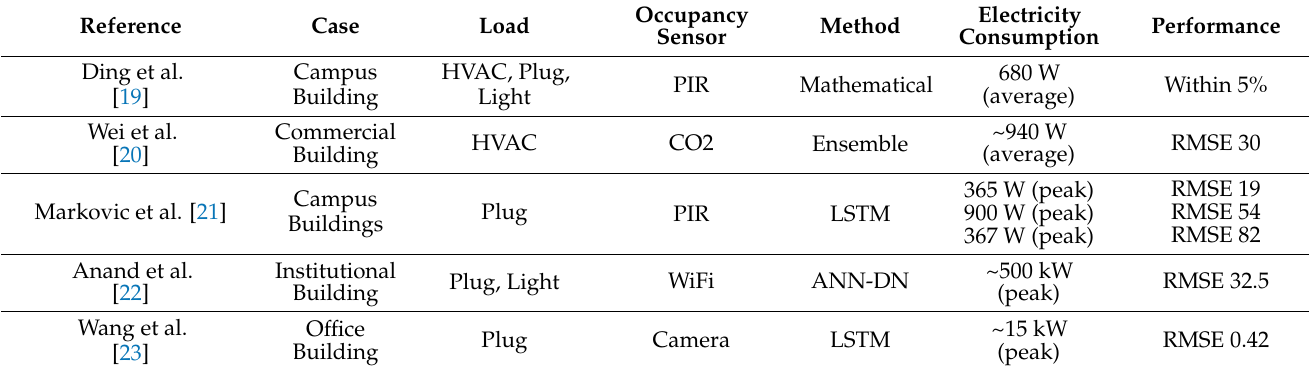
Table 1. Comparison of previous studies for energy consumption prediction using